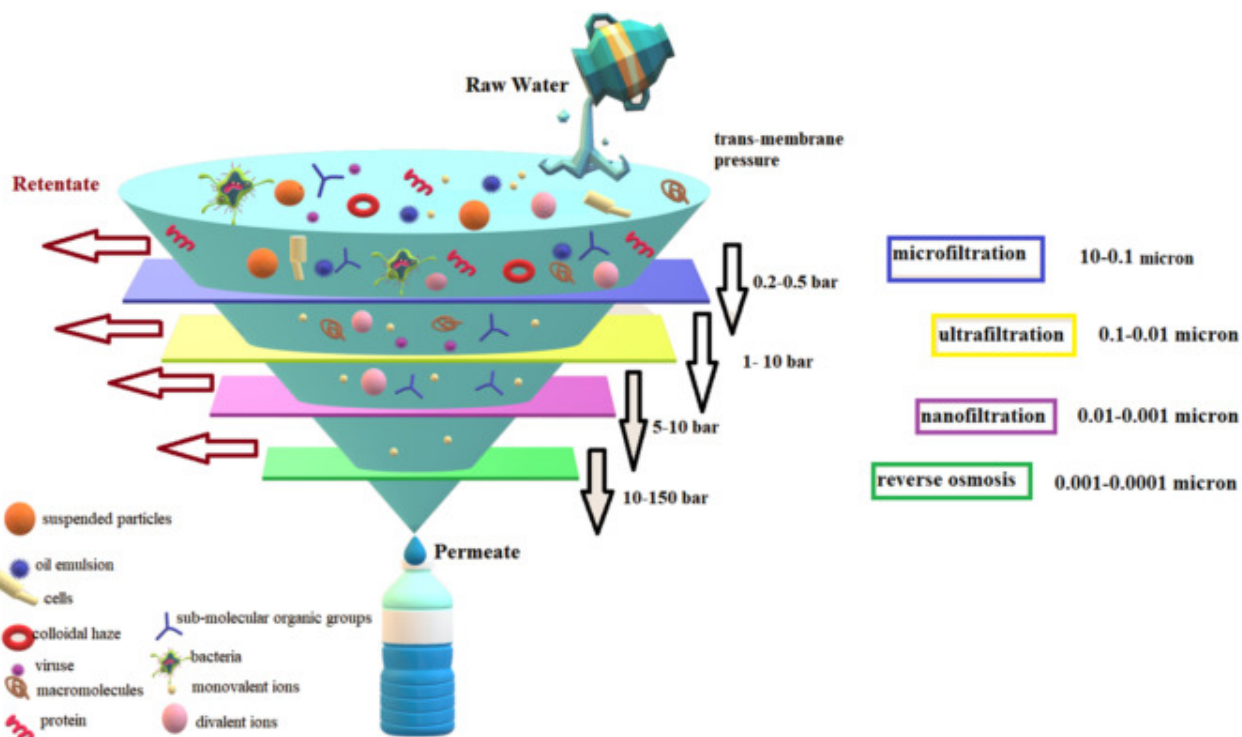
Figure 8. Capabilities of different separation/adsorptive membranes using microfiltration (MF), ultrafiltration (UF), nanofiltration (NF) and reverse osmosis (RO) processes. Adapted with permission from Hmtshirazi et al. [19]. Copyright (2022) Elsevier.